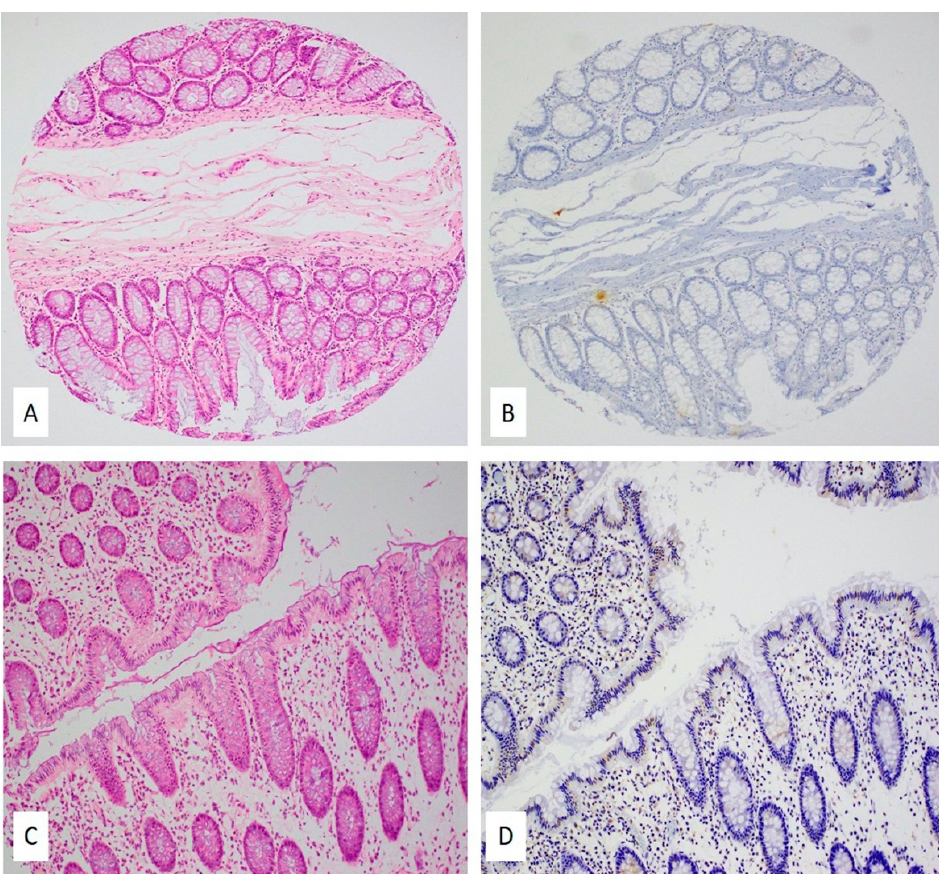
Figure 2. ( A – D ) HPV and EBV expression in normal colonic mucosa; ( A , C ) hematoxylin and eosin slides (H&E) of two cases with normal colonic mucosa, 10×; ( B , D ) corresponding IHC slides for E6 protein ( B ) and LMP1 protein ( D ) revealed no protein expression in the normal colonic epithelium; however, some intramucosal lymphocytes were positive for LMP1 protein (10×). Immunohistochemical staining was performed using the standardized avidin–biotin immunoperoxidase method.